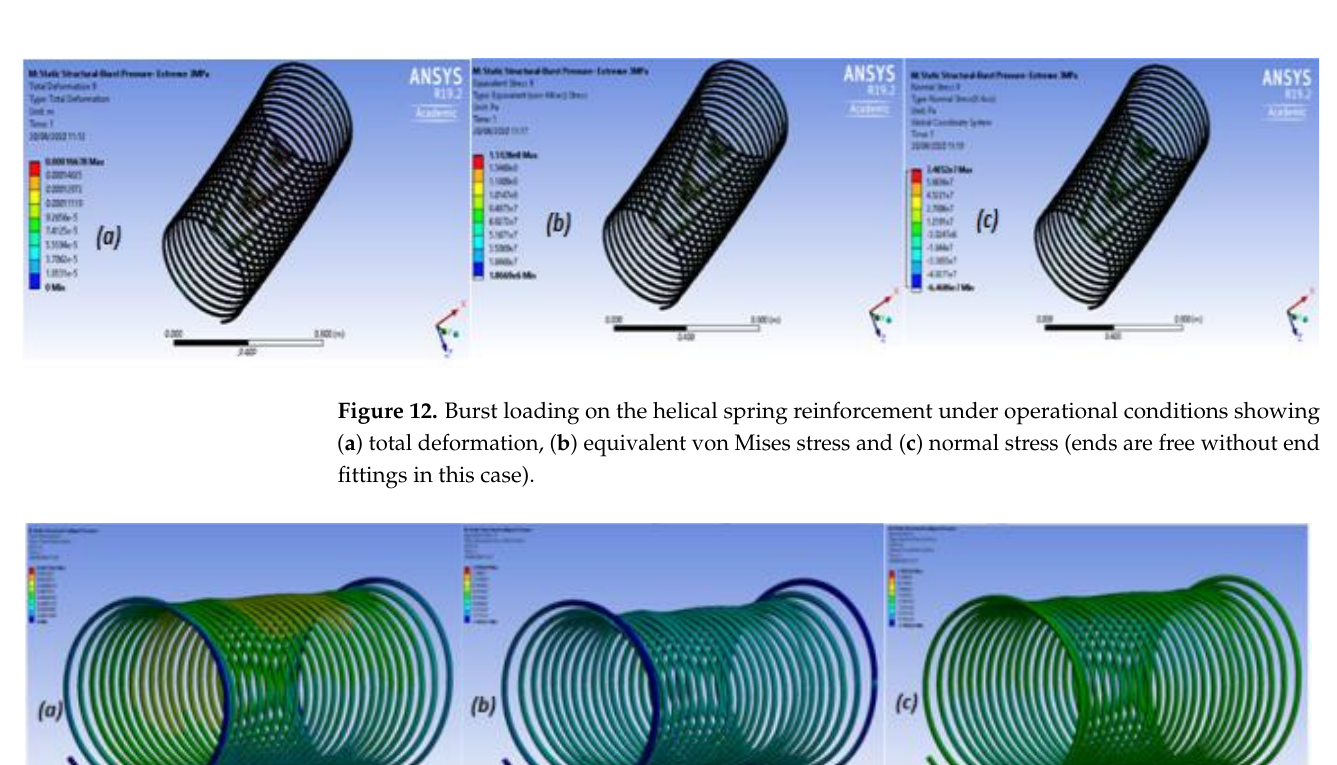
Figure 11. Burst loading on the helical spring reinforcement under extreme conditions showing ( a ) total deformation, ( b ) equivalent von Mises stress and ( c ) normal stress (ends are free without end fittings in this case).